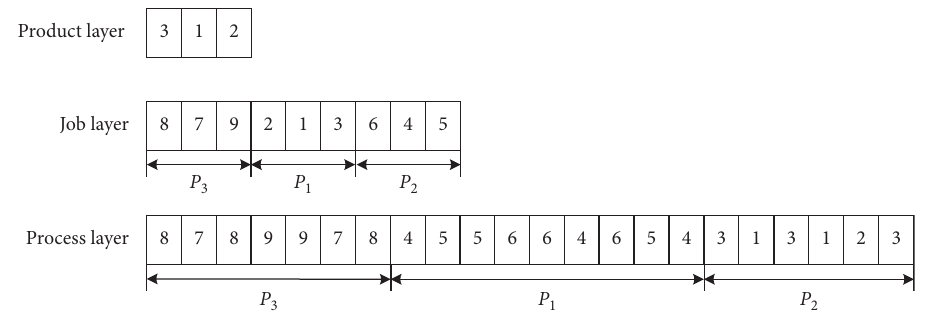
Figure 4: An example of the PA